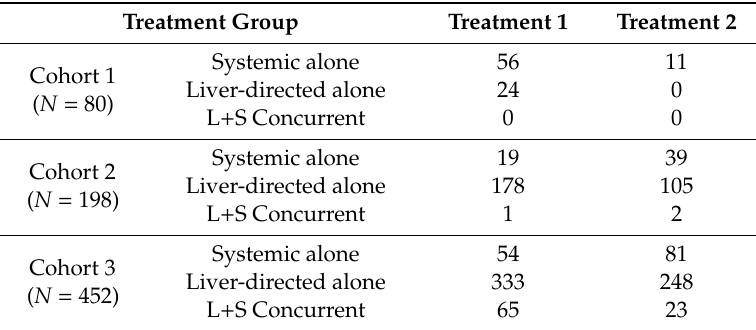
Table 2. Treatment breakdown by Treatment 1 and 2.